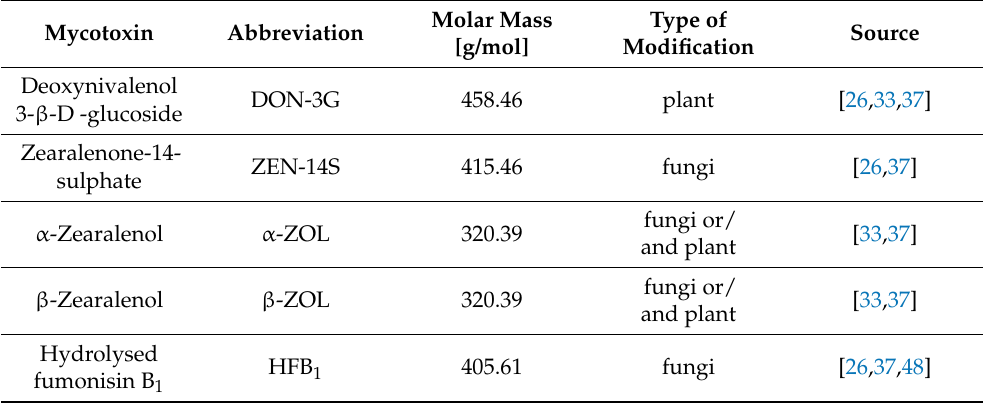
Table 2. Selected modified toxins produced by Fusarium , characteristic of maize